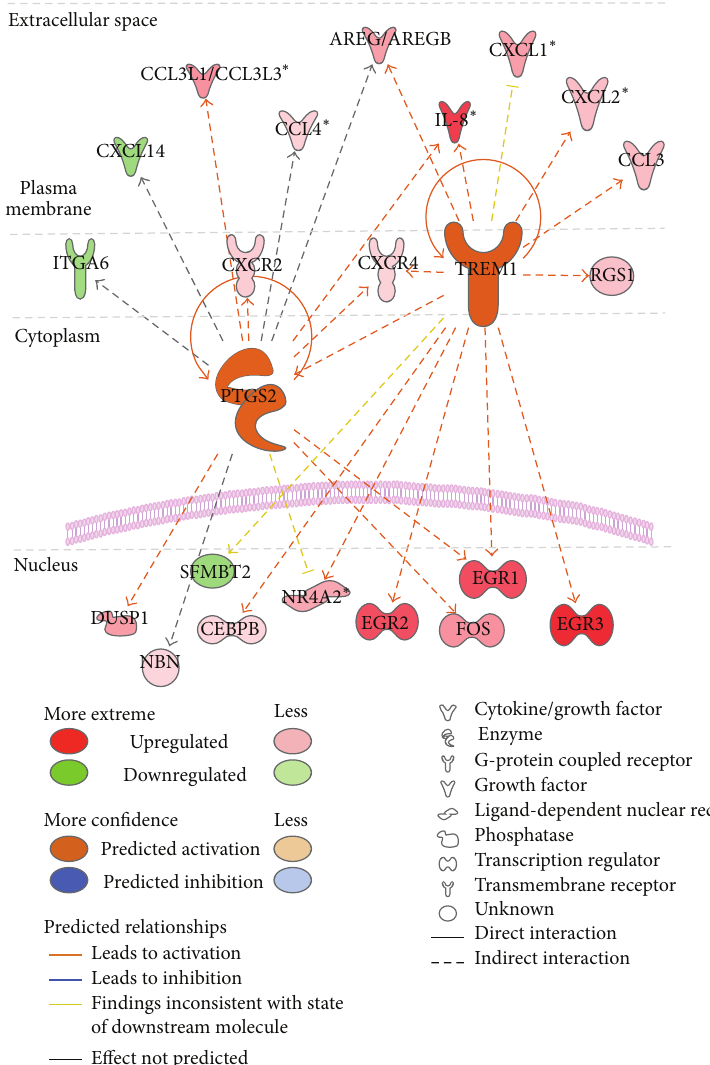
Figure 5: The network of TREM1 and PTGS2 (COX-2) upstream regulators and their target molecules, evaluated in the peripheral blood cells of breast cancer patients compared with healthy donors (Ingenuity Pathway